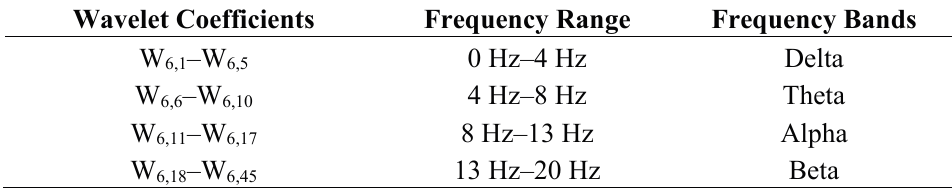
Table 2. Frequency bands extracted from the wavelet coefficients and grouped into corresponding frequency bands. The respective frequency bands are derived by finding the mean of the respective wavelet coefficient